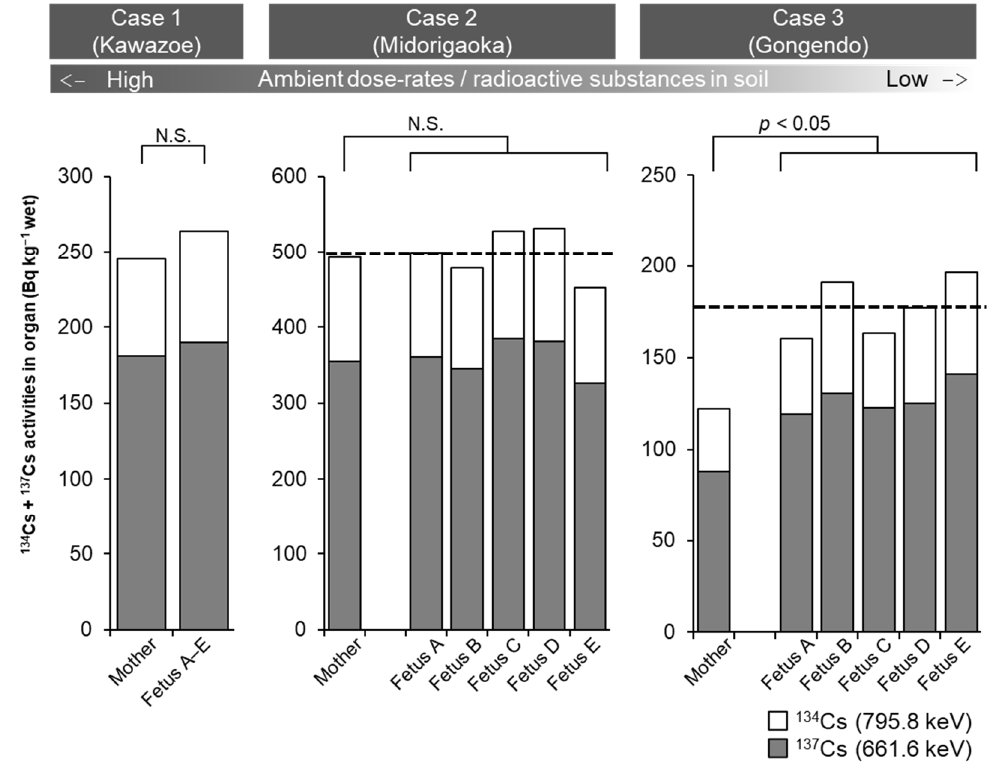
Figure 6. Comparison of 134 Cs + 137 Cs activity concentrations in the cat maternal uterus and fetuses. Dashed line in Case 2 and 3 represents mean activity concentrations of fetuses.